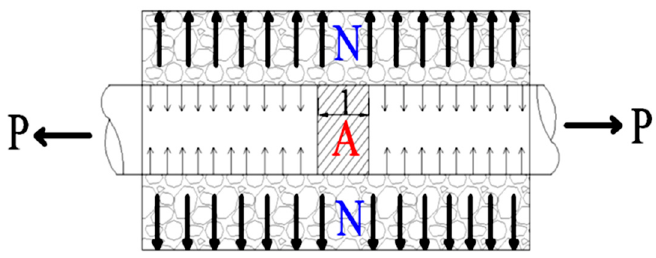
Figure 2. Normal reactional force (N) under pull-out force (P) [40].